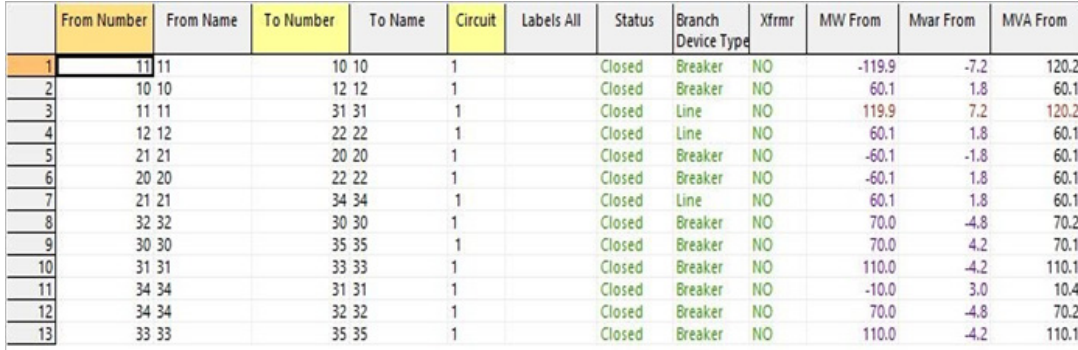
Figure 6. Measurement values of transmission line under the normal scenario.